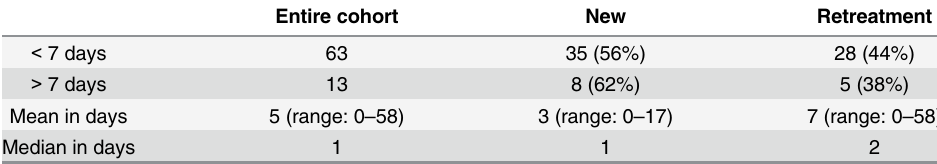
Table 5. Duration of treatment initiation.